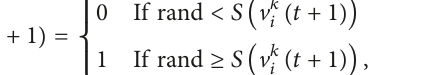
Figure 1: Sigmoid transfer function.